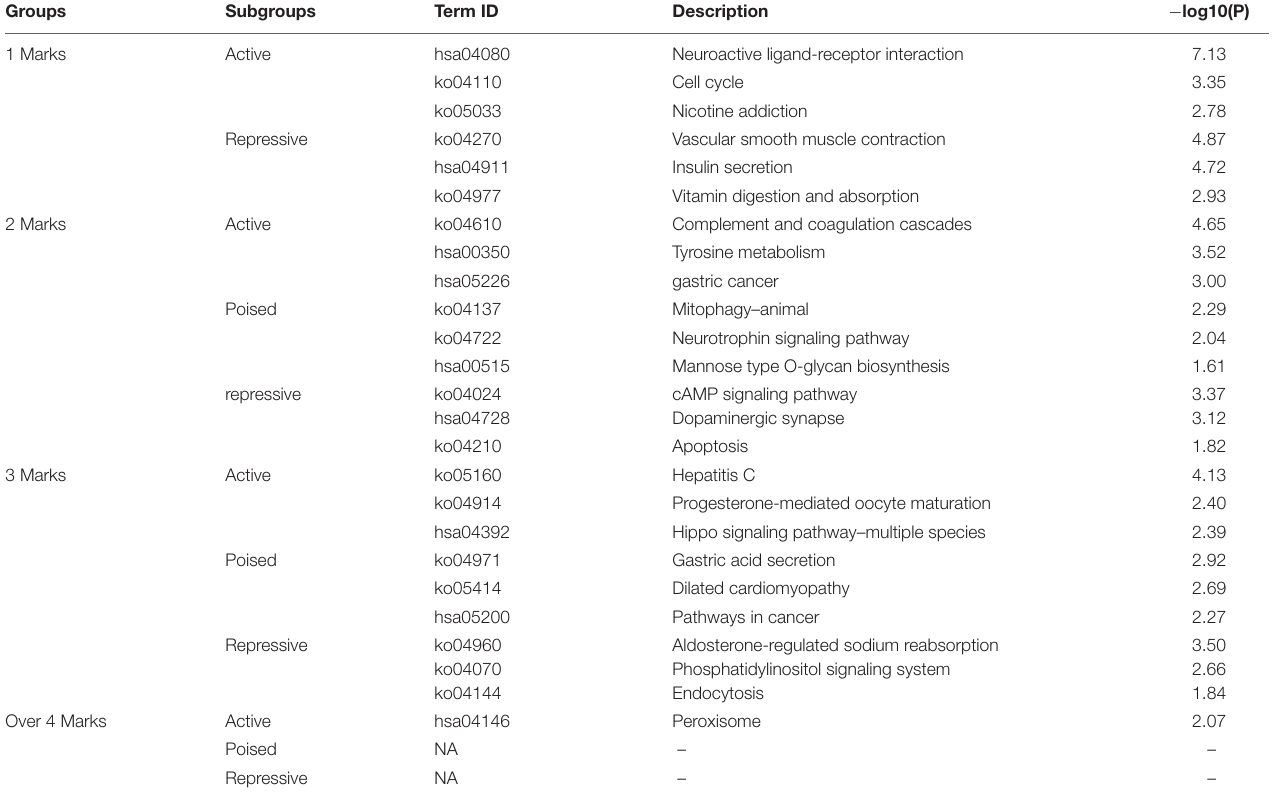
TABLE 2 | KEGG enrichment analysis of up- and down-regulated genes in each subgroup with P -value cutoff 0.05. Groups